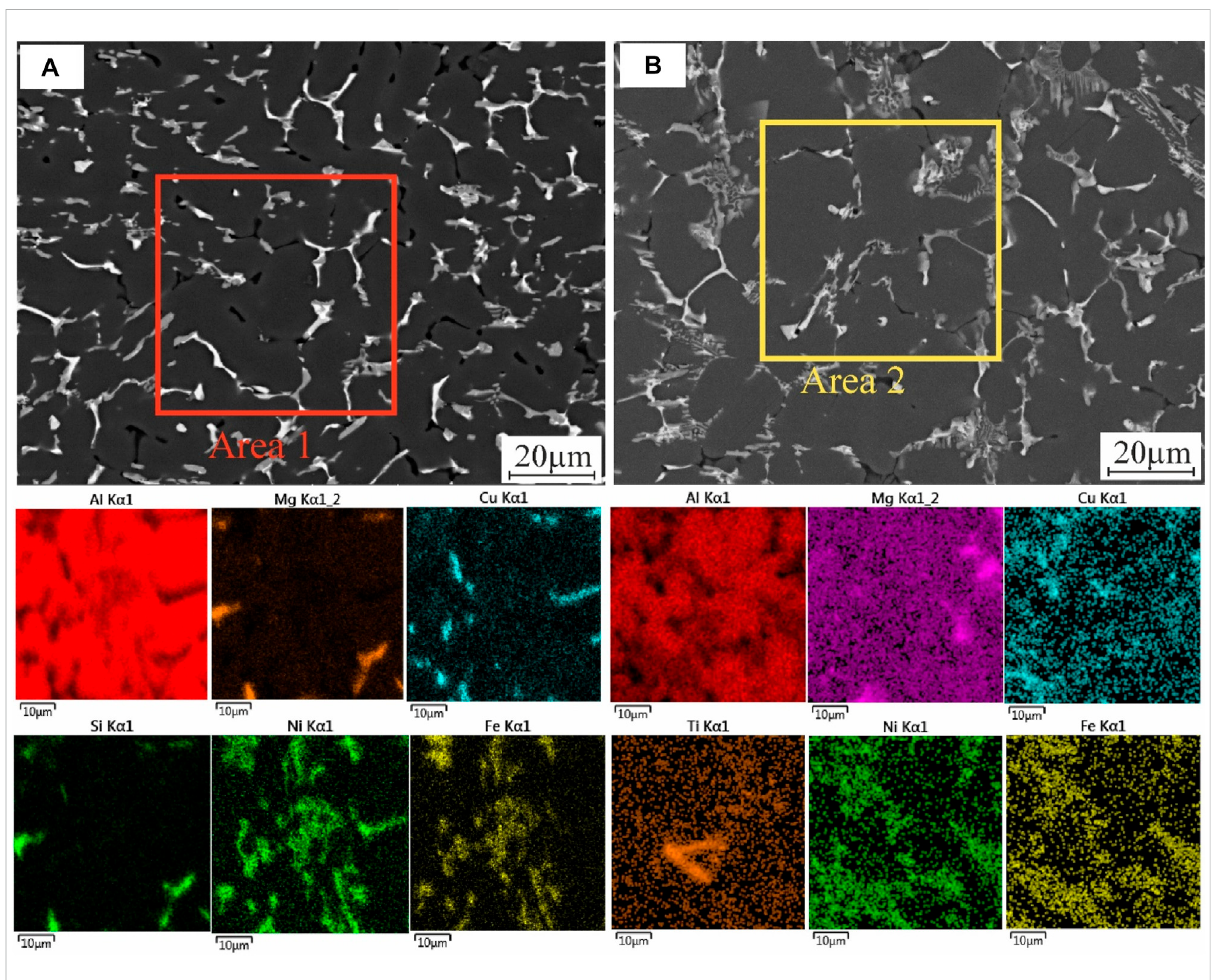
Figure 2. When TiB modi fi ers were added to the casting process, it resulted in a re fi nement of the grains, which led to an equiaxed re fi ned dendritic structure. Without undergoing any extra processing, the improved A242 + TiB alloy displayed grains that were homogenous, equiaxed, and re fi ned to be three times smaller than those of the standard alloy. The standard A242 alloy was analyzed using ImageJ software, and the average grain size was observed as 470 ± 80 μ m, while the modi fi ed A242 + TiB has a 35 ± 5 µm average grain size. The A242 alloy, much like the reference alloy, had big grains and a typical coarse